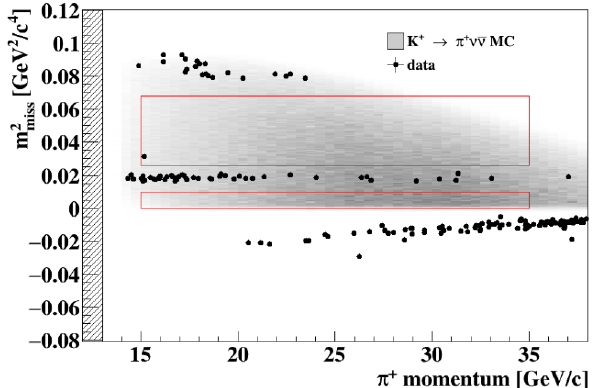
Figure 4. Squared missing mass as a function of the pion three-momentum for PNN-triggered data events (dots) passing the event selection, except for the cuts on m 2 to the distribution of K + → π + ν ¯ ν MC events; red lines define the signal regions. The event observed in SR2 is